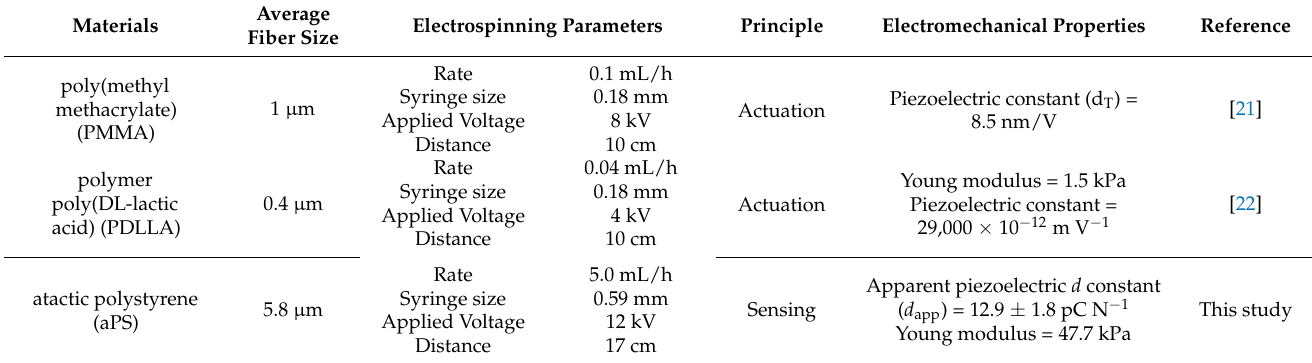
Table 1. Comparison of different non piezoelectric materials fabricated via electrospinning and the electromechanical